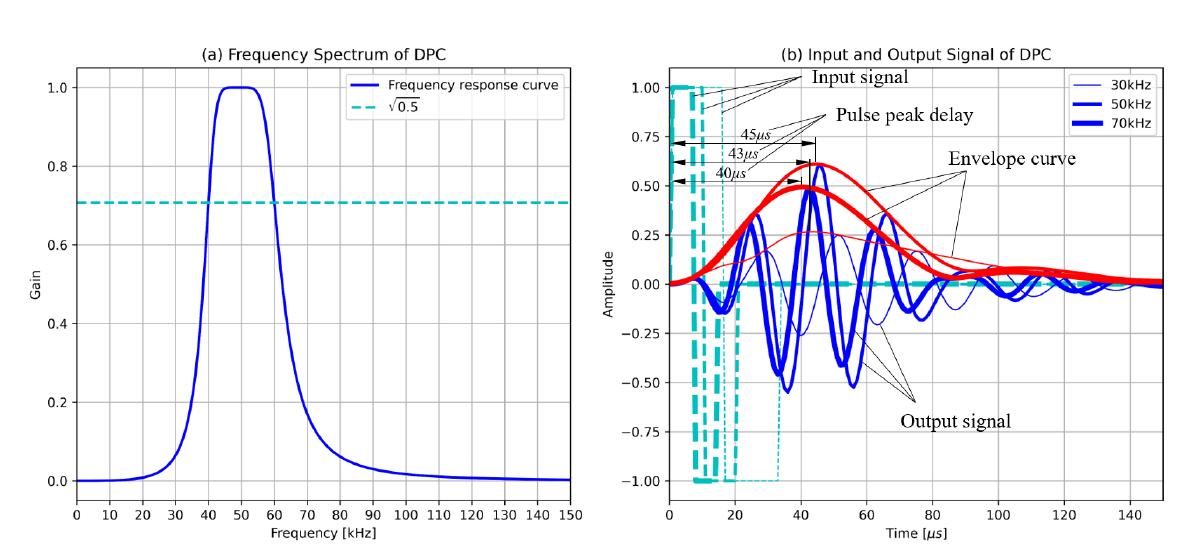
Figure 1. Frequency response spectrum and input/output signal of DPC (Dry Point Contact).